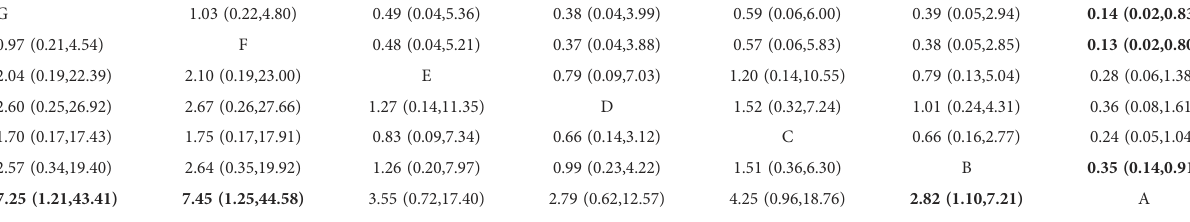
TABLE 5 Ef fi cacy comparison of 7 interventions (random-effects model of MCMC method).